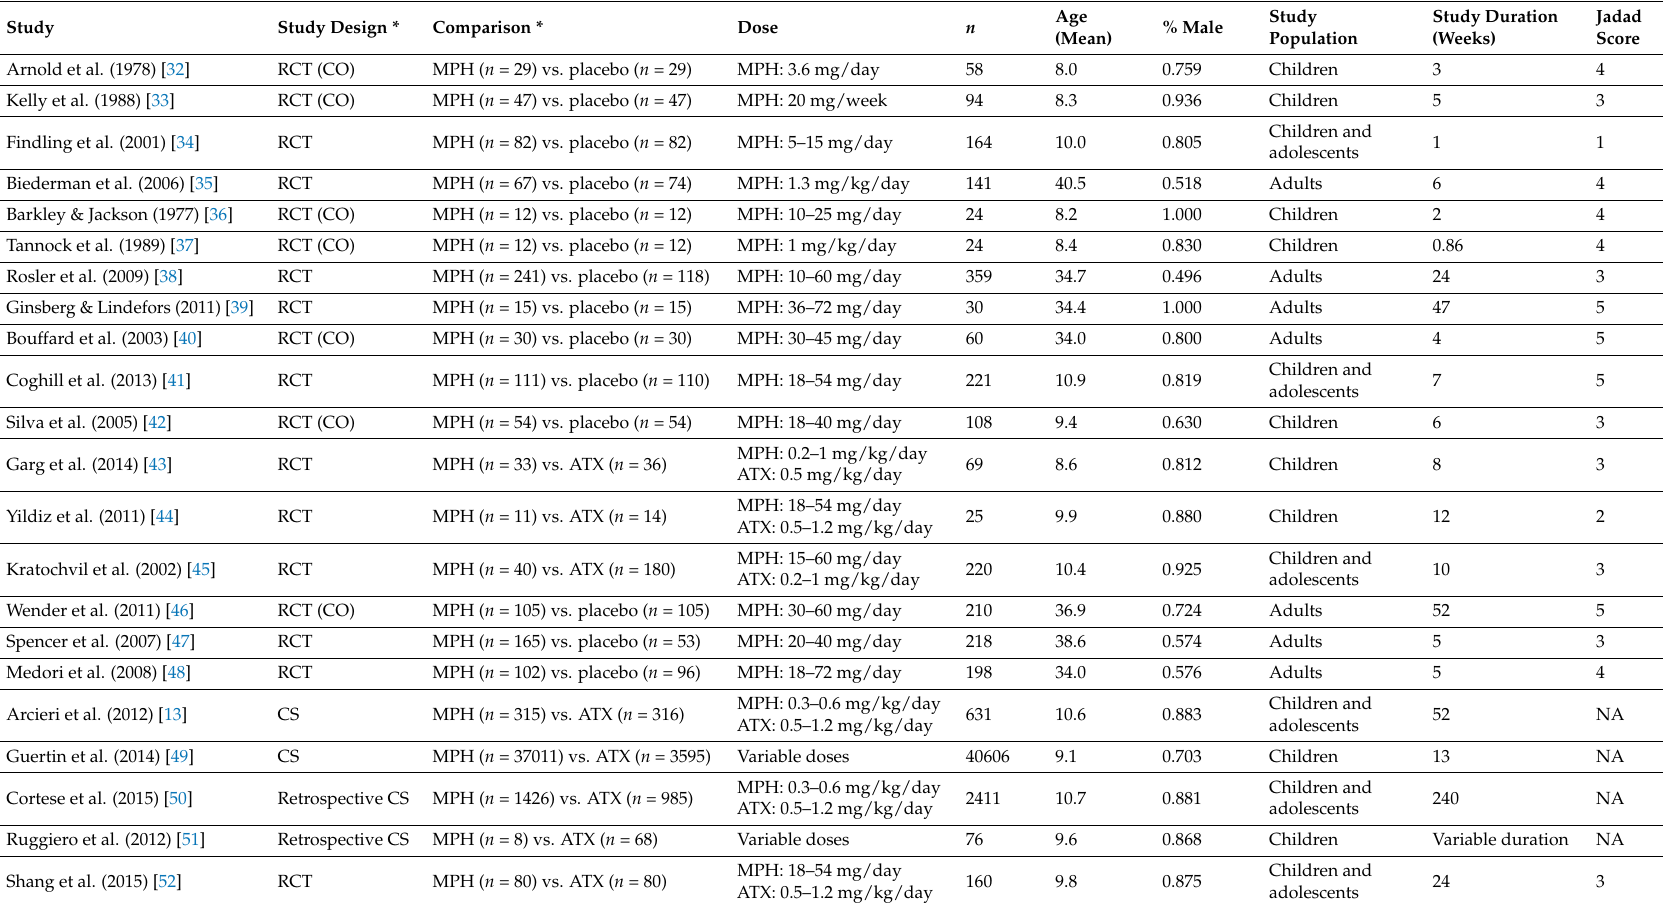
Table 1. Characteristics and quality of controlled trials comparing methylphenidate and either placebo or atomoxetine in patients with attention deficit hyperactive